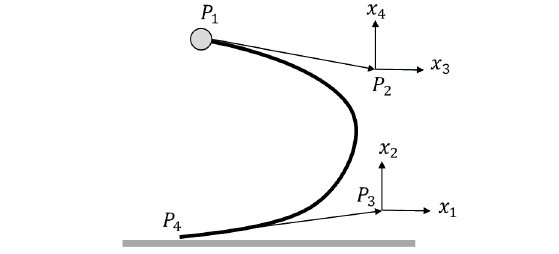
Figure 1. Points 𝑃 (cid:2869) , 𝑃 (cid:2870) , 𝑃 (cid:2871), and 𝑃 (cid:2872) are control points of the B-spline. While the positions of 𝑃 (cid:2869) and 𝑃 (cid:2872) are fixed, the positions of 𝑃 (cid:2870) and 𝑃 (cid:2871) change to optimize the force-displacement characteristics of the prosthesis.